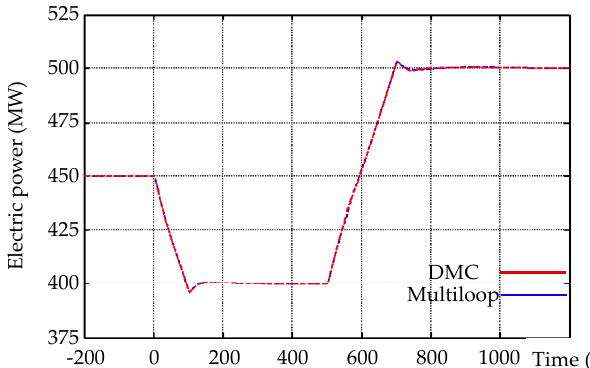
Figure 9. Comparison of electric power output of 600-MW plant.